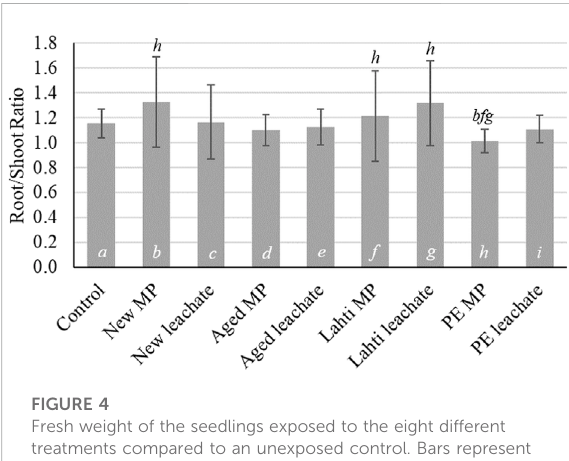
FIGURE 4 Fresh weight of the seedlings exposed to the eight different treatments compared to an unexposed control. Bars represent mean fresh weight (in grams) ± standard deviation ( n = 24). Signi fi cant differences are indicated by the letter above the bars ( p <